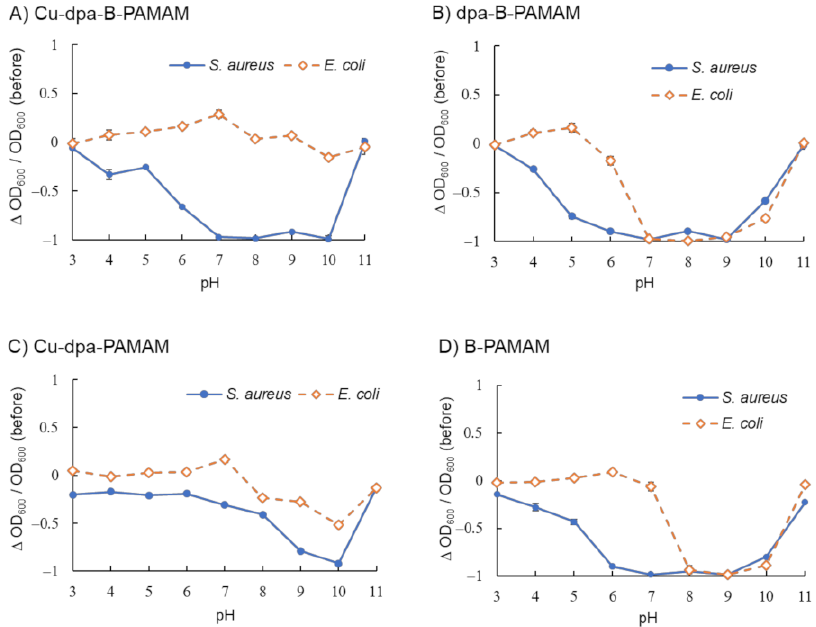
Figure 5. Turbidity changes in bacterial suspensions containing Cu-dpa-B-PAMAM ( n = 3). [probe] = 3.3 µ M; [Cu 2+ ] = 13.2 µ M or none; [bacteria] = 2.3 × 10 8 CFU · mL − 1 ; [HEPES or CAPS] = 5.0 mM. Bars are expressed as SD for three separate experiments. ( A ) Cu-dpa-B-PAMAM, ( B ) dpa- B-PAMAM, ( C ) Cu-dpa-PAMAM, ( D ) B-PAMAM. The number of dpa modifications was 4 and the number of boronic acid modifications was 7 for ( A − C ) and 8 for ( D